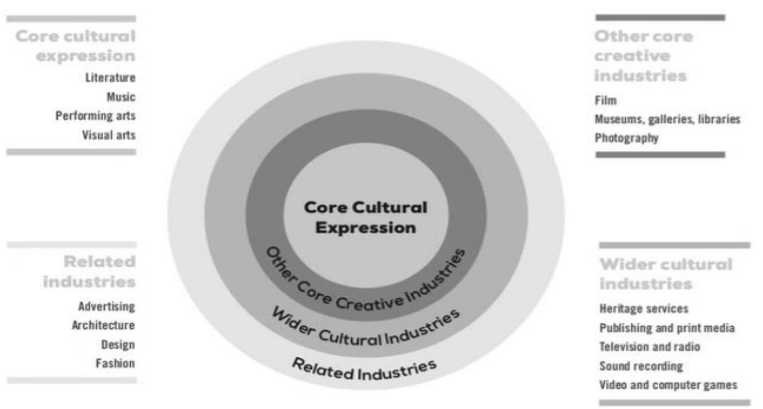
Figure 2: Modelling the cultural and creative industries: The concentric circles model; Source: Throsby, D., (2008) Publishing as the starting sector of the Vilijun